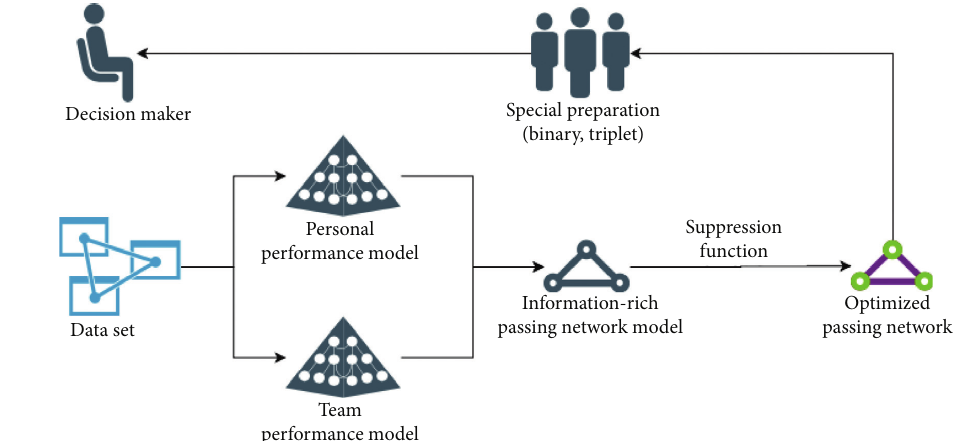
Figure 2: Overview of mining strategy for football social